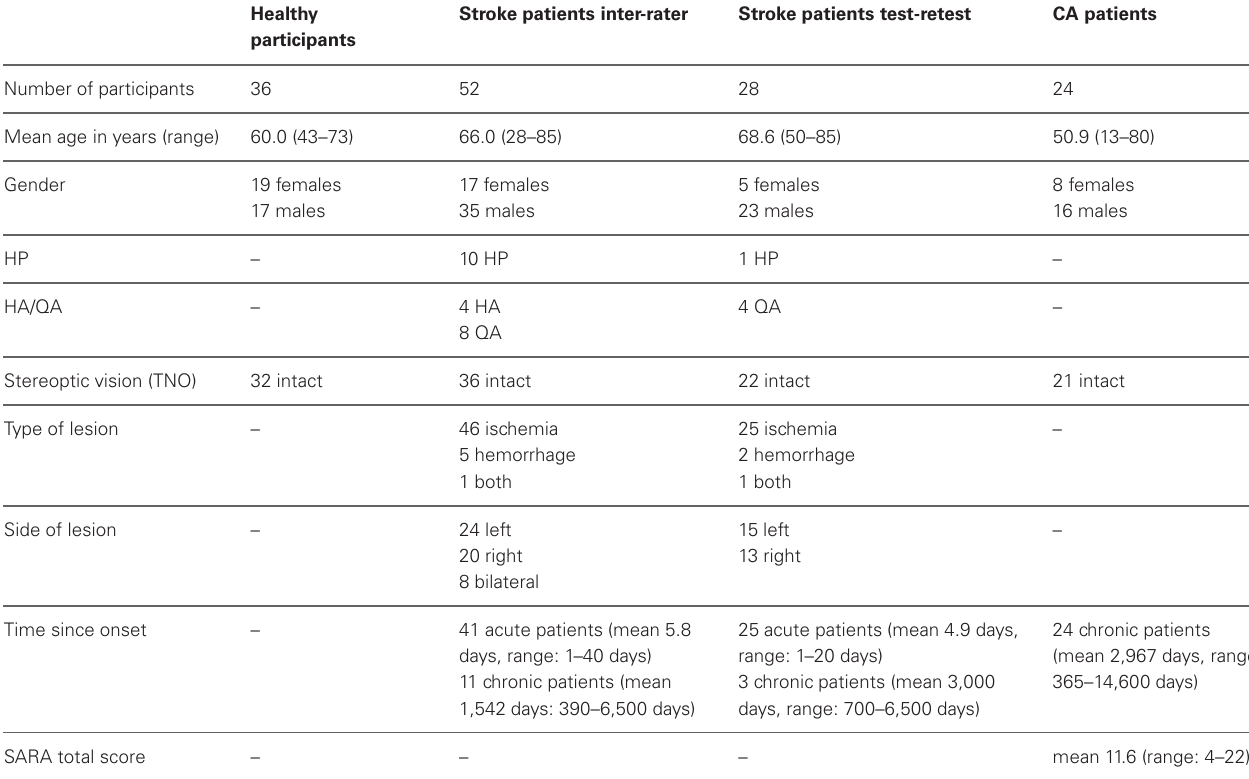
Table 1 | Demographic details for all participant